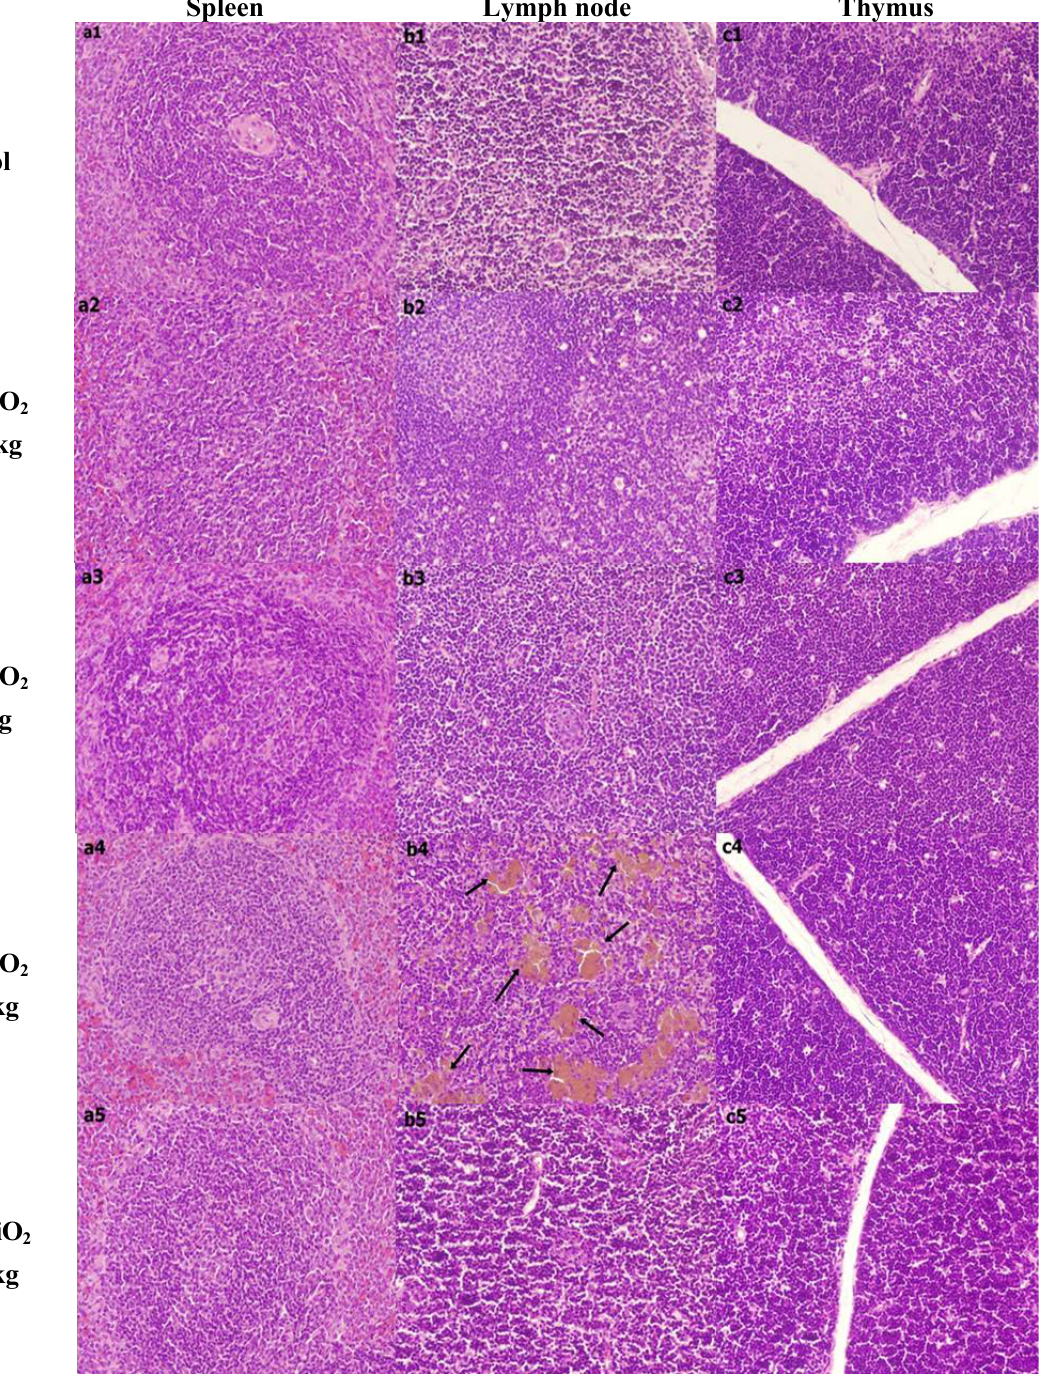
Figure 1. Histopathology of the tissue in Sprague-Dawley (SD) rat caused by an intratracheal instillation with nano-TiO2 for 28 days (200×). Hematoxylin and eosin stains of spleen ( a1 – a5 ); lymph node ( b1 – b5 ) and thymus ( c1 – c5 ) tissues of rat. Black arrows point to brown particulate